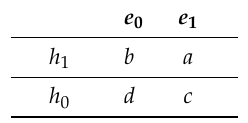
Table 2. The four conditional probabilities of a binary classification form a Shannon channel.